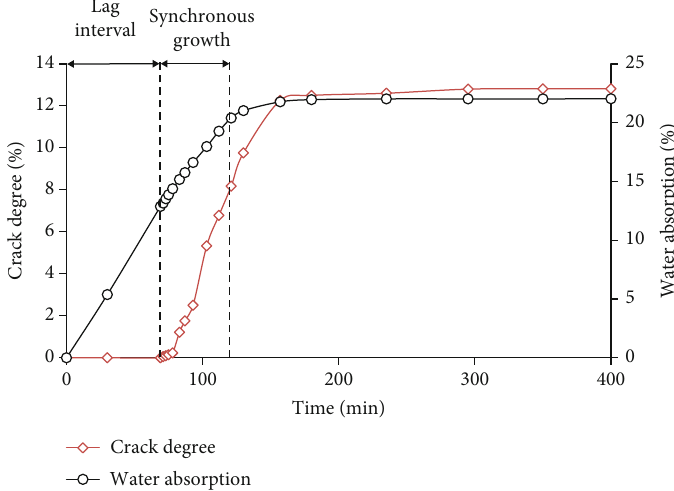
Figure 14: Curves of crack degree and water absorption over time of 2# sample.